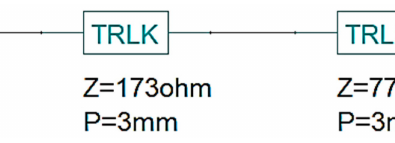
Figure 16. Two-stage quarter wavelength transformers. The whole system is symmetrical in the horizontal plane and is completed by an additional 2 × 2 elements left and right (Figure 17).